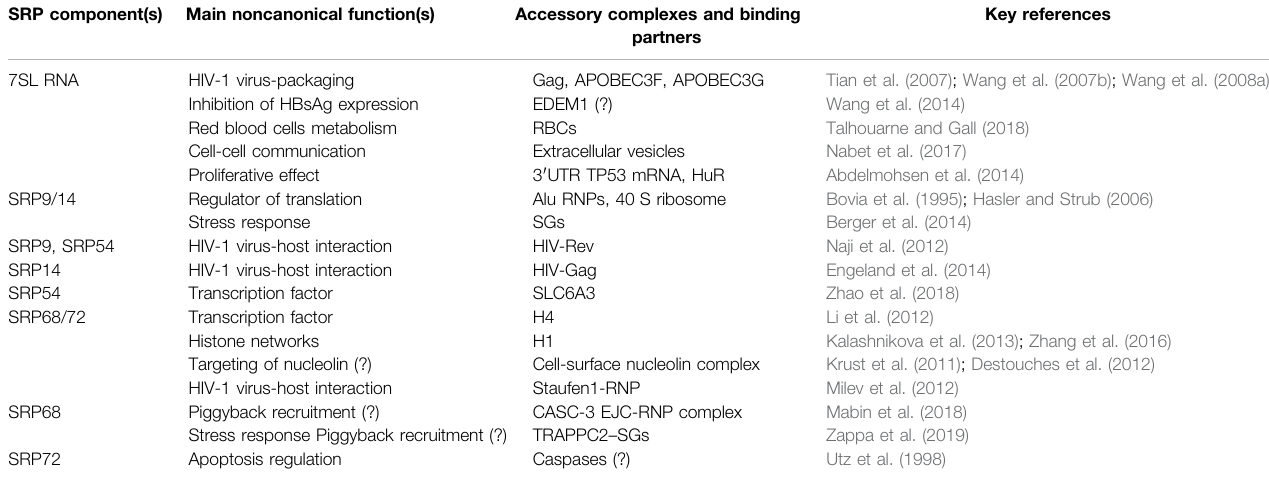
TABLE 1 | Noncanonical functions and binding partners of SRP components. SRP component(s) Main noncanonical